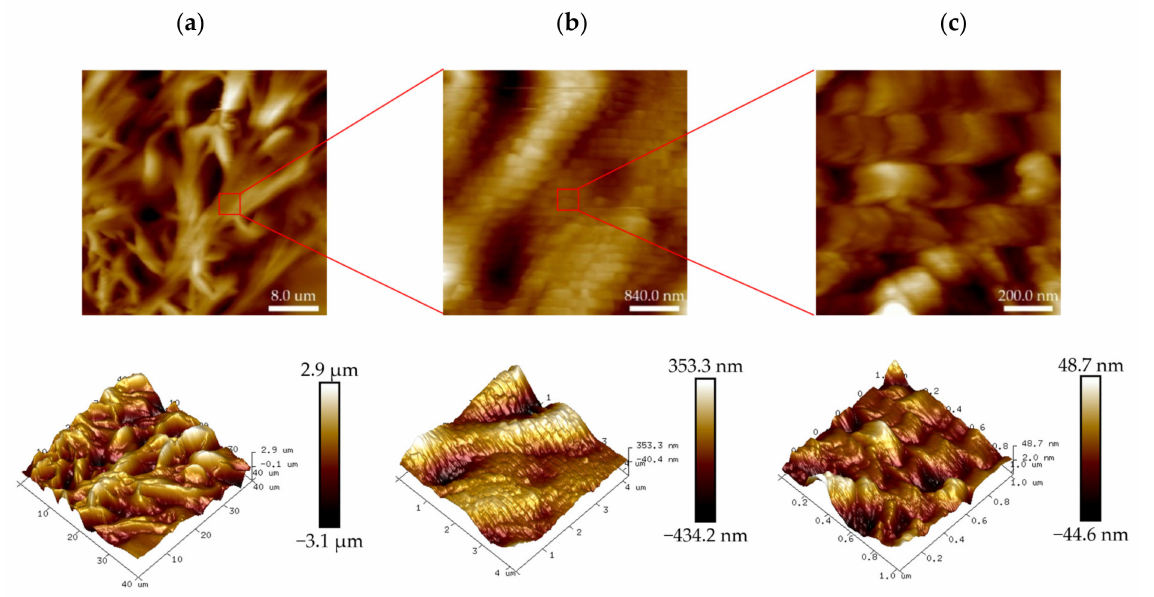
Figure 3. Two-dimensional (2D) and three dimensional (3D) images of the PHRO gel in deionized water with AFM. ( a ) Scanning area is 40.0 µ m × 40.0 µ m; ( b ) scanning area is 4.2 µ m × 4.2 µ m; ( c ) scanning area is 1.0 µ m × 1.0 µ